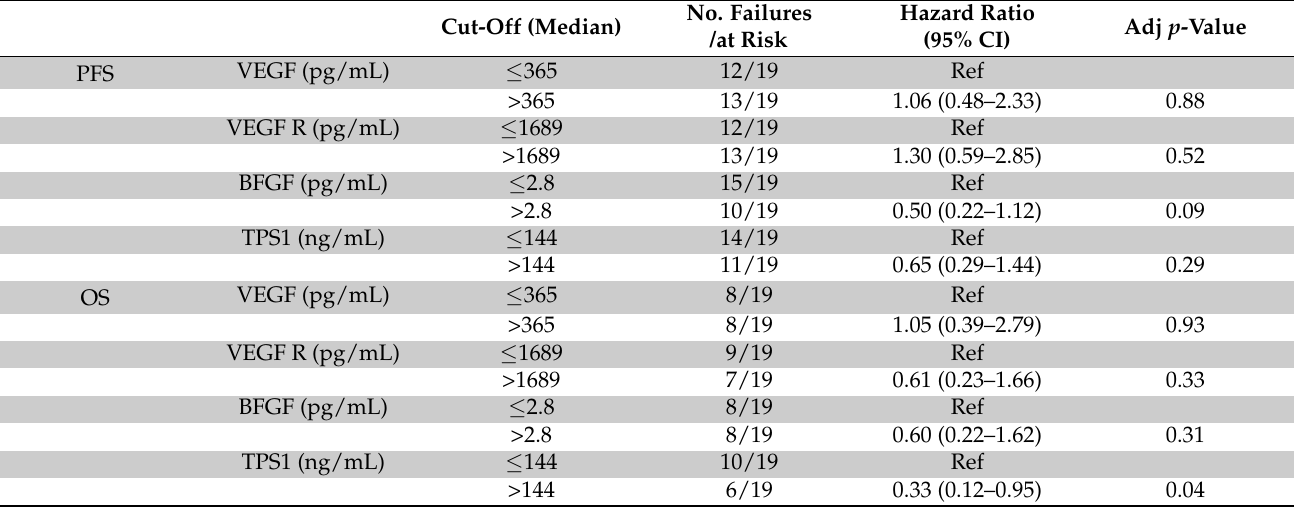
Table 3. Progression-free survival and overall survival risk estimates according to BAT median cut-off values at